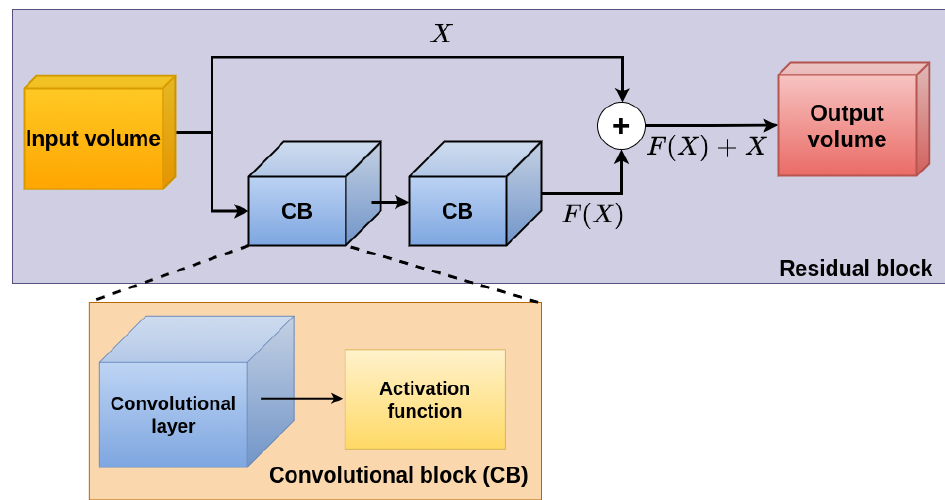
Figure 4. Residual block implementation.